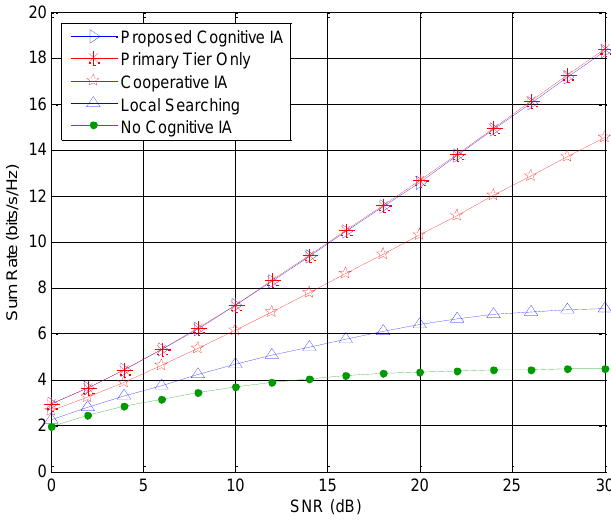
Figure 3. Sum rate comparison of the macrocell with different precoding algorithms.